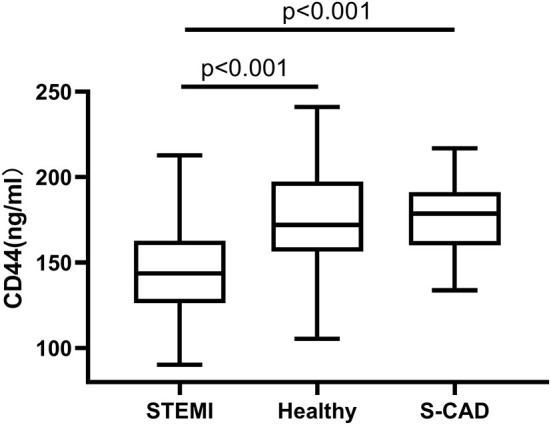
Relations of plasma CD44 levels among patients with STEMI, S-CAD and healthy subjects. HA, hyaluronan; STEMI, ST-Segment–Elevation Myocardial Infarction; S-CAD, Stable Coronary Artery Disease.